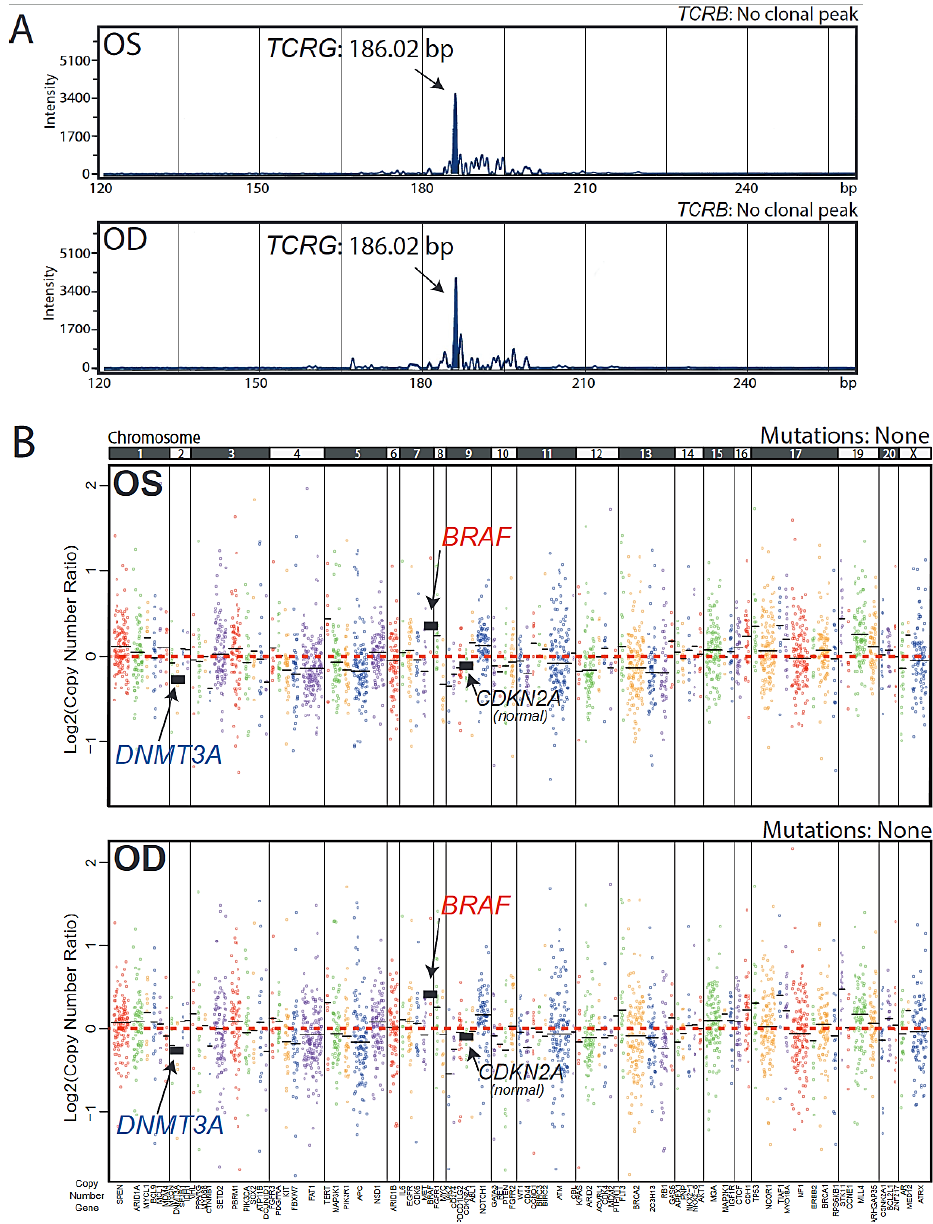
Figure 2. DNA analysis of vitreous liquid biopsy samples. ( A ) DNA obtained from vitreous fluid from each eye underwent clonal T cell receptor (TCR) rearrangement PCR testing covering ~90% of the most common rearrangements in the TCRB and TCRG genes. Assays were run in duplicate with negative controls (one replicate shown per sample). Clonal rearrangements were defined as peaks identical between replicates that were at least 2× higher than the third highest peak. Capillary electropherogram plots of band intensity over fragment length show a positive PCR result for TCRG rearrangement at 186 bp, identical in both eyes, at ~10% frequency. No TCRB-positive bands were observed in either sample. ( B ) NGS using the OCP version 1 panel was performed on each eye sample. Copy number plots are shown as log2 copy number ratio (amplicon level ratio between read counts in the tumor sample and read counts in a composite of normal samples, normalized for sequencing depth and GC content). Dots represent individual amplicons, dots of the same color represent a gene, and black horizontal bars represent average gene-level estimates (coverage- weighted). Altered/relevant genes are highlighted. No mutations were observed in either sample.